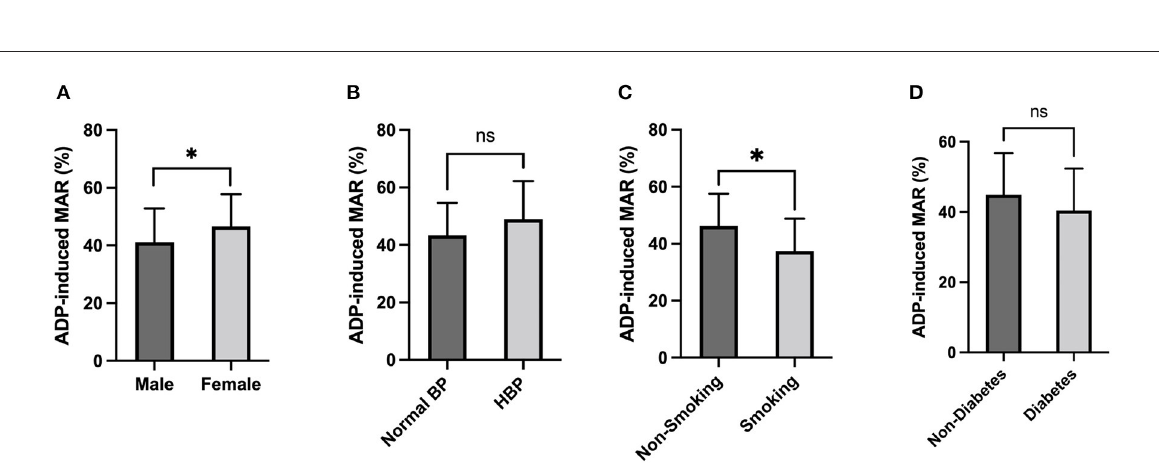
FIGURE2 ADP-induced platelet aggregation stratified by Sex and Comorbidities. ADP-induced platelet maximal aggregation rate (MAR) in healthy subjects stratified by Sex (A) , Hypertension (B) , Smoking (C) , and Diabetes (D) . *: P < 0.0332, ns: P >